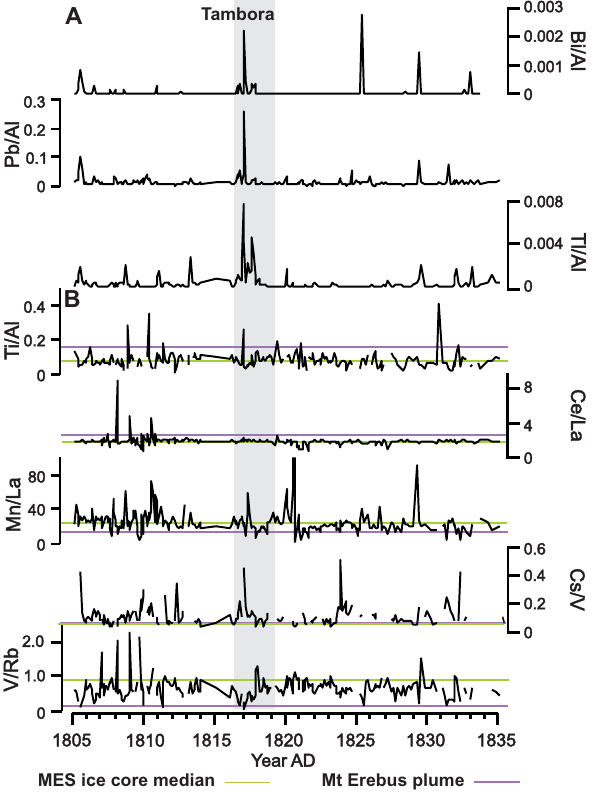
Fig. 3. (A) Bi, Pb and Tl concentrations normalised to Al (a terres- trial element) across the Mt. Tambora eruption marker (grey shad- ing). (B) Trace element ratio records from the MES core for the same time period, plotted with values for the Mt. Erebus plume (pur- ple line) (Zreda-Gostynska et al., 1997) and the median values of the entire MES ice core record (green line). Breaks in the record occur where the concentration of an element is below the ICP-MS detec- tion limit. Information on Bi, Pb and Tl content of the Mt. Erebus plume is not available.